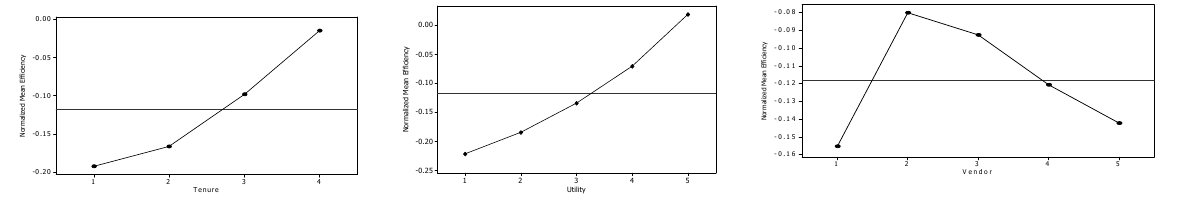
Fig. 7 (c). Vendor developed IT ser- vice vs . Conformance